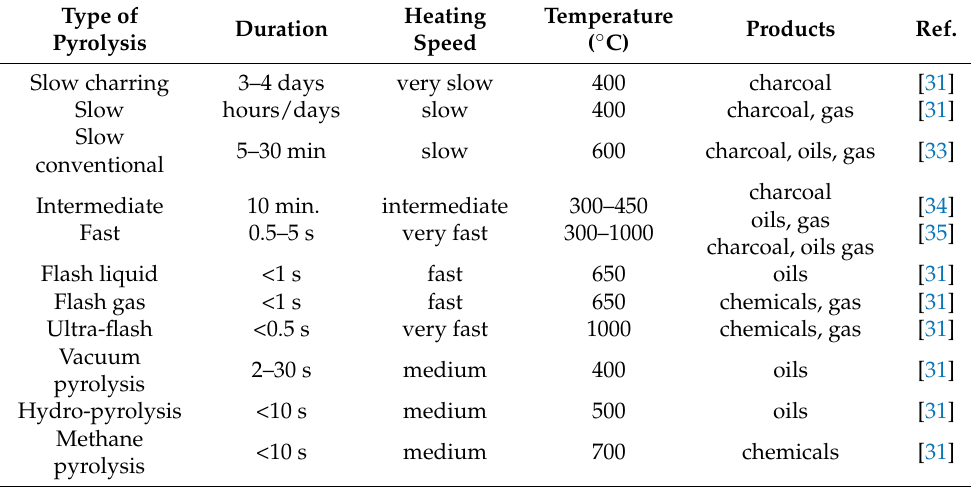
Table 1. Characteristics of individual types of pyrolysis (own